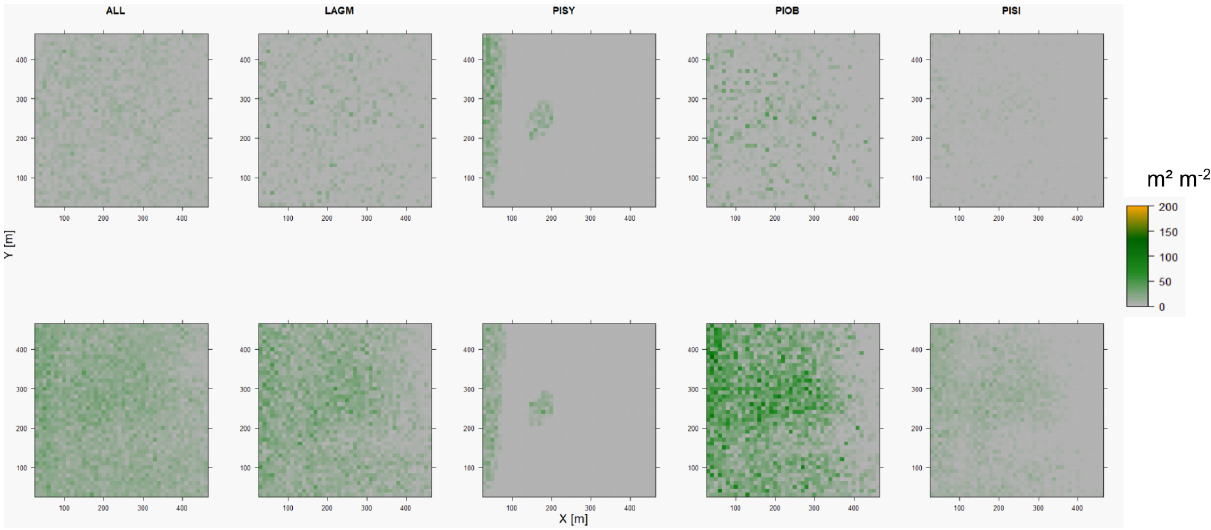
Figure D4. Leaf area index (LAI) values of the CryoGrid grid aggregated at year 2030 at Lake Khamra. Upper row shows LAVESI–CryoGrid coupled; lower row shows LAVESI simulations. LAGM: Larix gmelinii ; PIOB: Picea obovata ; PISI: Pinus sibirica ; PISY: Pinus sylvestris .